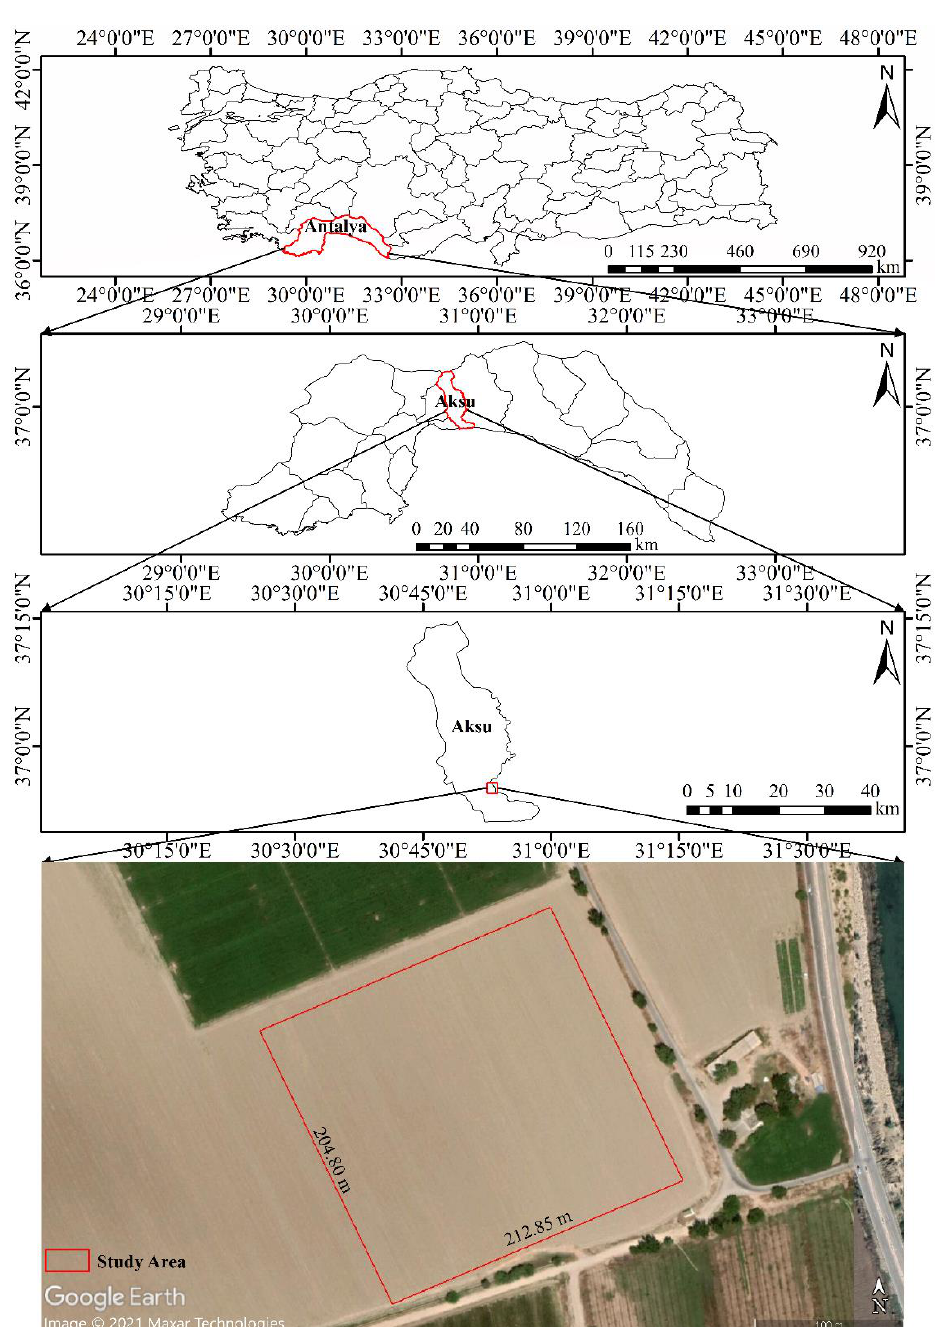
Figure 1. Location map and Google Earth image of the study